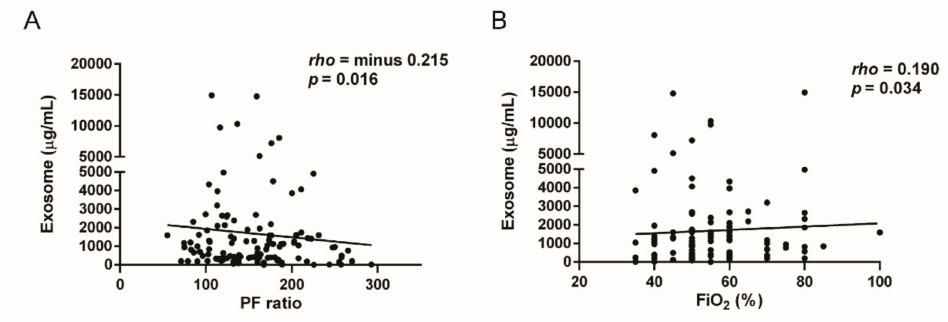
Figure 2. ( A ) Correlation between the level of bronchoalveolar lavage (BAL) exosomes and the PaO 2 / FiO 2 (PF) ratio. ( B ) Correlation between the level of BAL exosomes and FiO 2